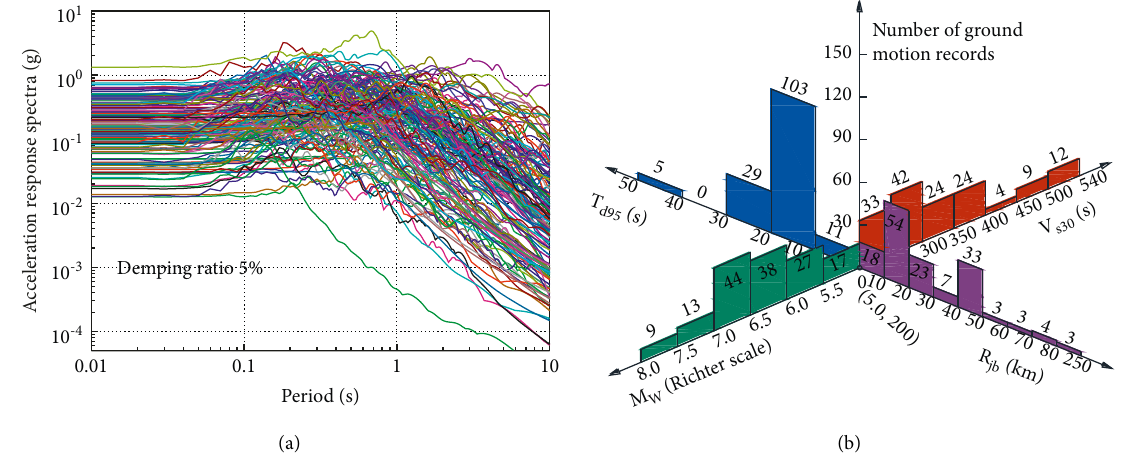
Figure 4: (a) Acceleration response spectra and (b) main